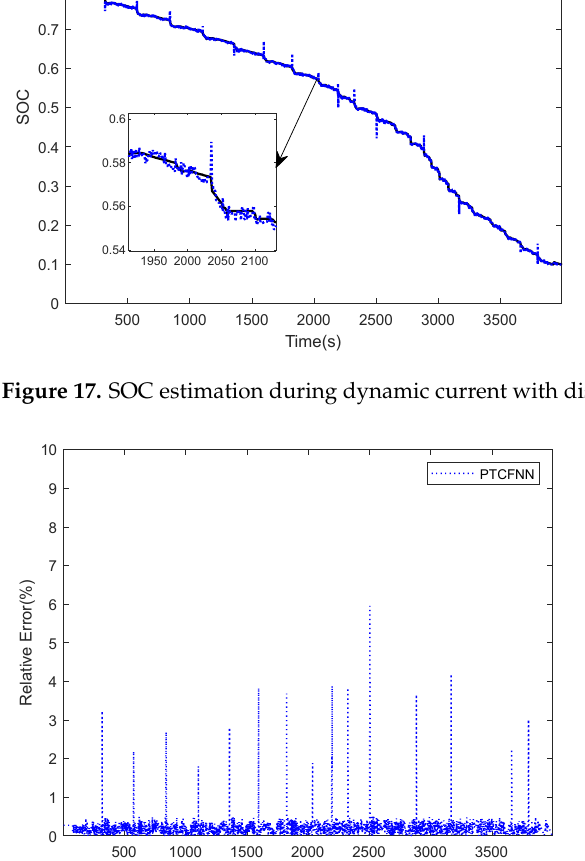
Figure 18. Relative error during dynamic current with disturbance.